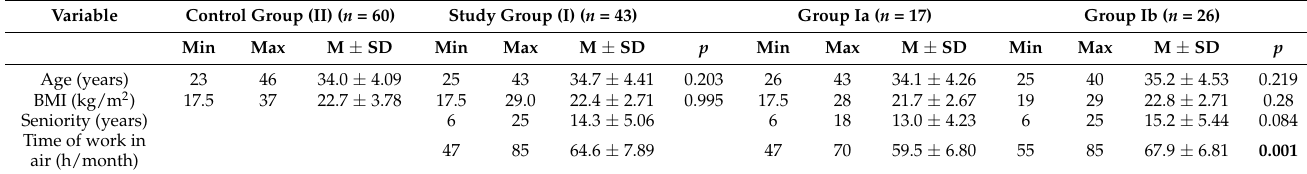
Note: Bolded is p < 0.001; Control group (II)—60 women of reproductive age who sought medical assistance due to marital infertility in whom the male factor was found to be responsible for problems with conception in the course of the diagnostic process; Study